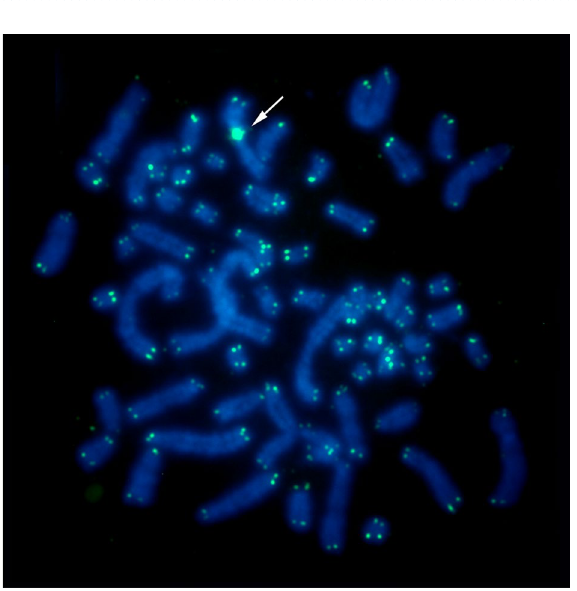
Figure 2. FISH results obtained from O. auyantepui (OAU; 2n = 64 ♀ 65 ♂ /FNa = 84), using HME whole chromosome probes 54 . Each box corresponds to an OAU pair shown in Fig. 1a that corresponded to more than one HME homologue. Single or multiple images are presented to exhibit full coverage with HME probes on OAU chromosomes. OAU chromosomal pairs identification are shown below the chromosomes, while HME probes are shown beside the chromosomes. An asterisk indicates a centromere. HME whole chromosome probes are shown in green (FITC) and red (CY3); the counterstaining is blue (DAPI).